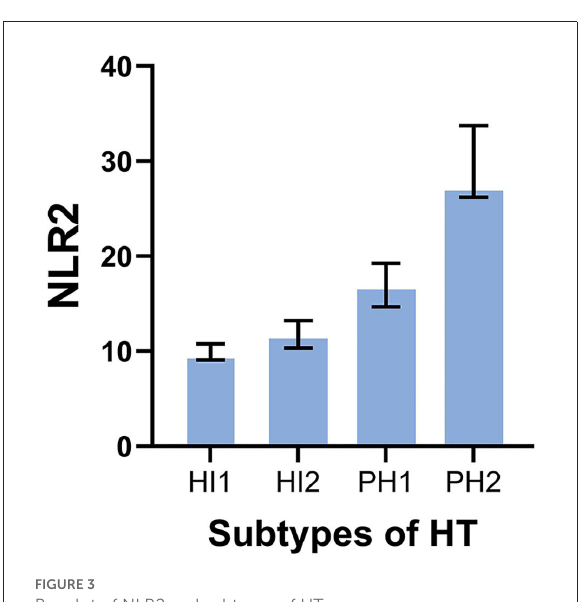
FIGURE3 Boxplot of NLR2 and subtypes of